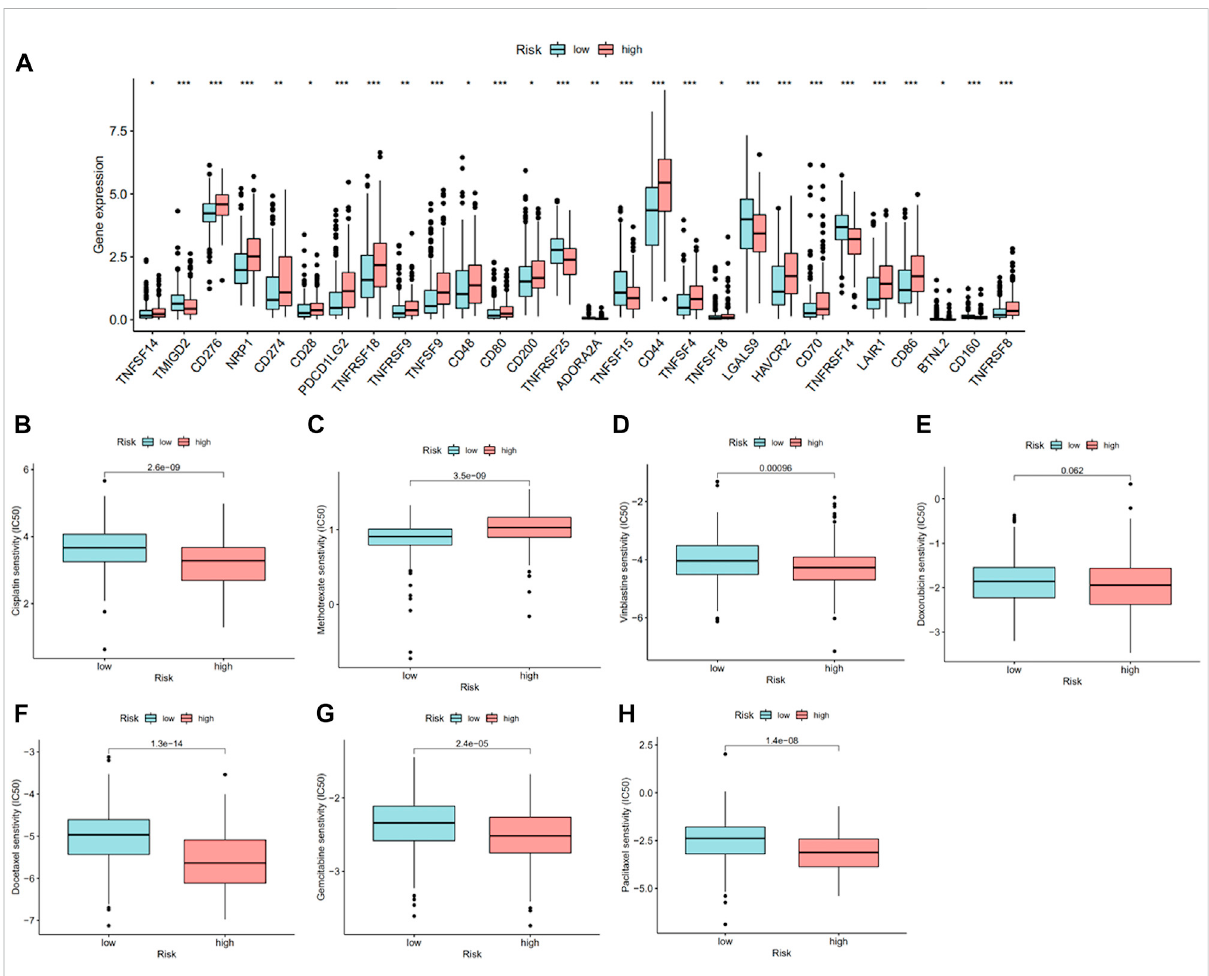
FIGURE 7 Checkpoint and drug response between high- and low-risk groups. (A) The signi fi cant distinction of checkpoint between high- and low-risk groups. (B – H) IC50 of cisplatin, methotrexate, vinblastine, doxorubicin, docetaxel, gemcitabine, and paclitaxel between high- and low-risk